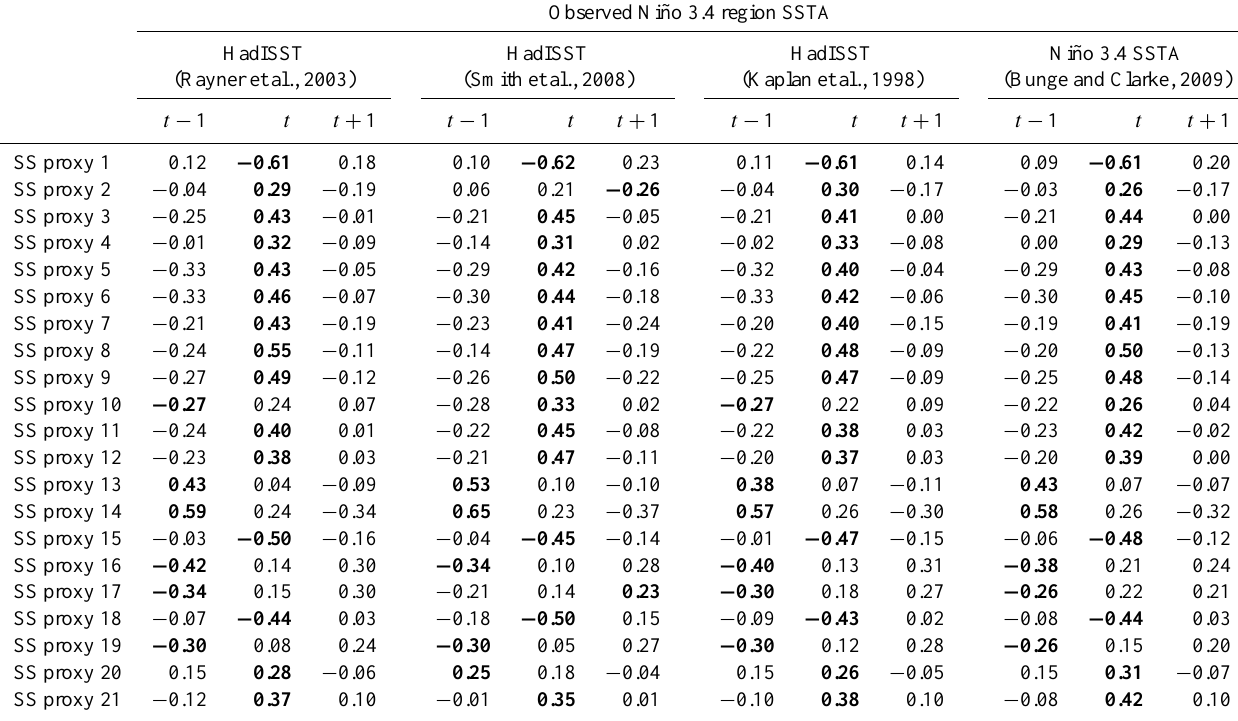
Table 4. Correlation coefficients with zero lag, and lead and lag times of one year ( t − 1 means proxy data lagging observed ENSO), calculated between the high pass filtered (HPF; 10yr cutoff) annual mean single station proxy network (Table 3) and the annual mean (July– June) observations of ENSO, represented by Niño 3.4 area-averaged (5 ◦ S–5 ◦ N, 120 ◦ W–170 ◦ W) SST anomalies during the overlapping instrumental period. The maximum correlation for each observational product is highlighted by bold